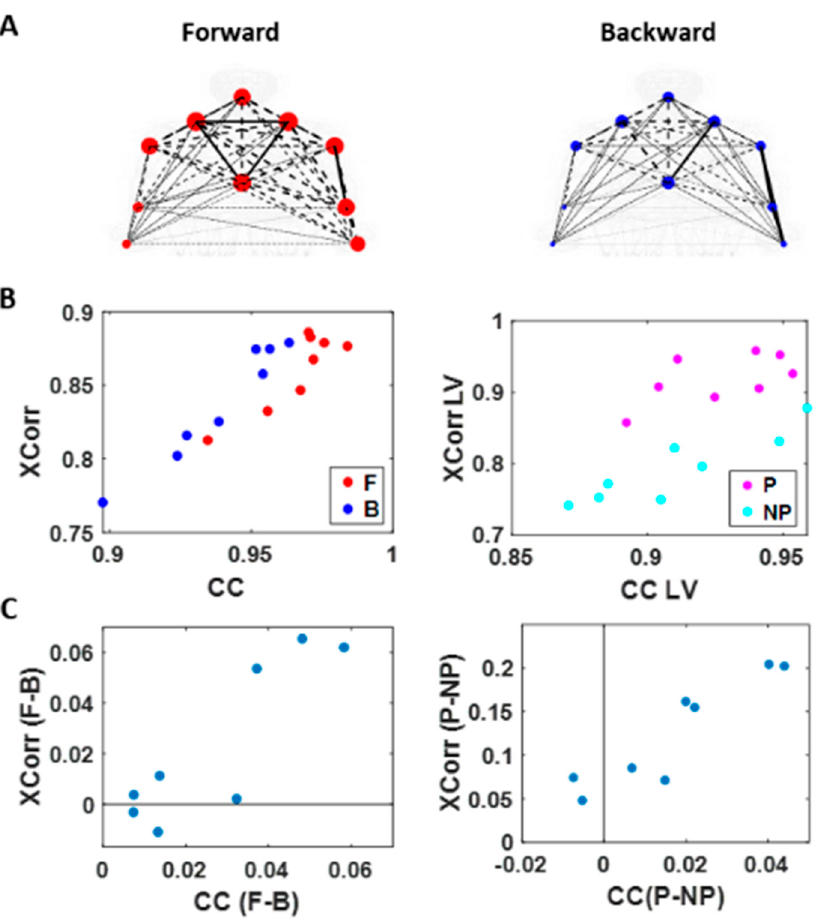
Figure 7. Network connectivity metric (cluster coefficient) and median cross-correlation differentiates between levels of intent. ( A ) Network visualization of a representative right-handed participant. Cross-correlation is represented by the line weight and cluster coefficient (CC) by the node size, during the forward (left) and backward movement segments (right). ( B ) Median cross-correlation (y-axis; Xcorr) and CC (x-axis) of linear speed for each participant’s movement segment (left) and different sides (right). Forward motions (red) and performing side (pink) exhibits higher cross-correlation and CC values than backward segments (blue) and non-performing side (cyan). ( C ) Median cross-correlation and CC difference for different movement segments (left) and different sides (right). Each participant’s data is denoted as a single marker. Higher motor intent tends to show higher cross-correlation and CC values.